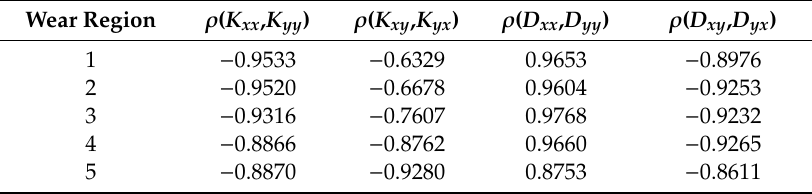
Table 3. Correlation coefficients of dimensionless dynamic coefficients for axial wear.